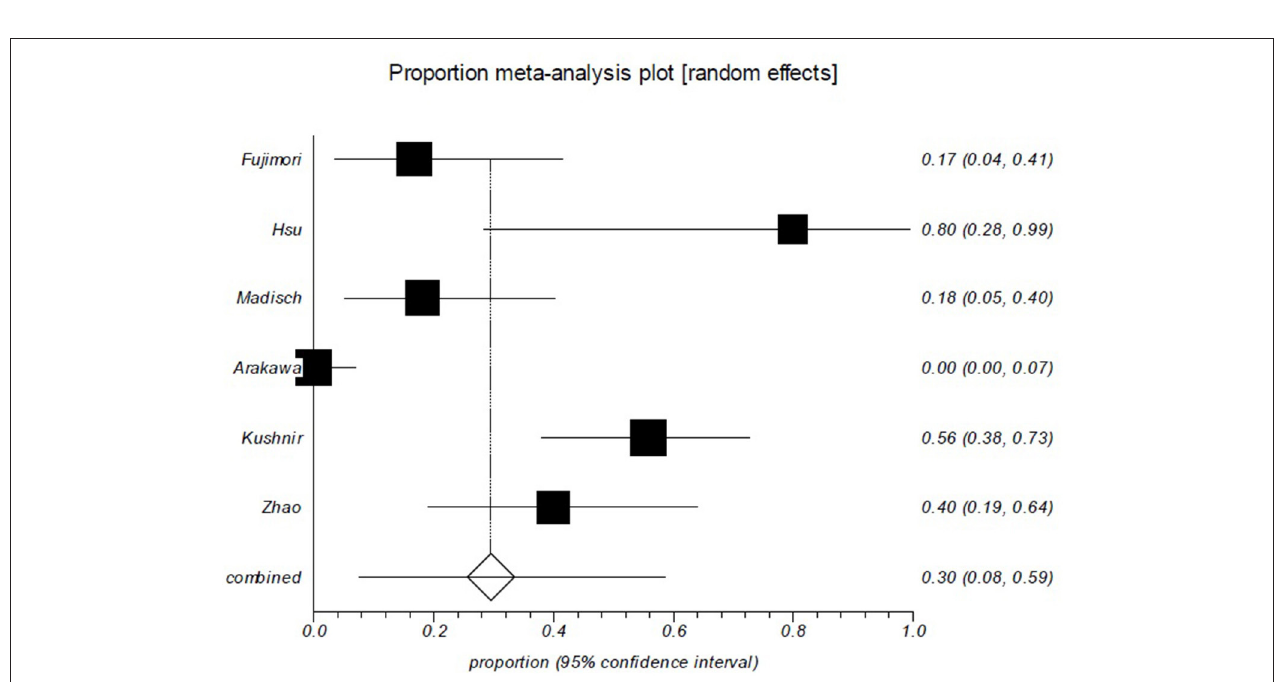
FIGURE 3 | Rebleeding rate of patients in the short follow-up group is ∼ 30%. Forest plot shows that 29.6% (95% CI: 7.5–58.6%) of the patients who had been followed up less than 2 years experienced rebleeding. There was evidence of heterogeneity among the studies ( p < 0.0001).